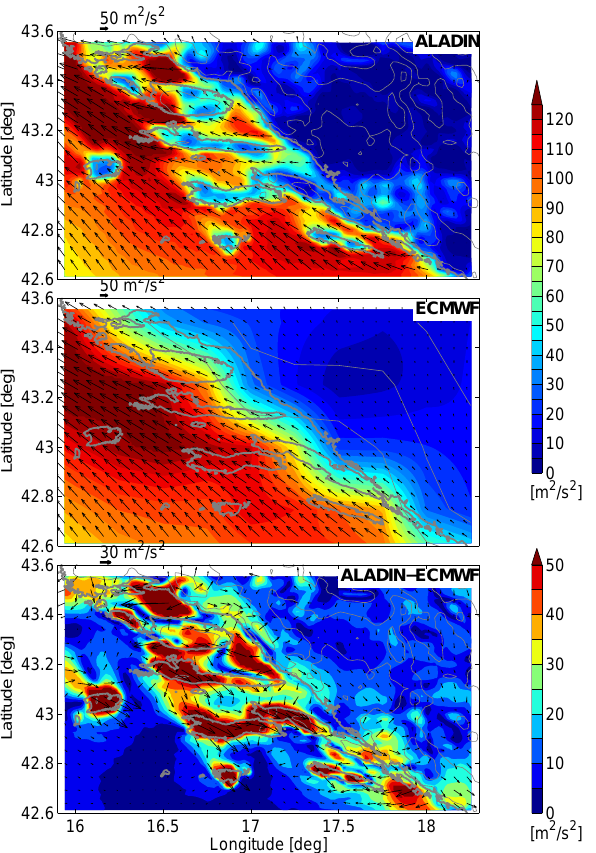
Fig. 8. Mean ASHELF-2 modeled vertically averaged currents for the Sirocco episode (Table 1) obtained with ALADIN and ECMWF forcing (top and center panels, respectively) and the differences be- tween these two (bottom panel). Additionally, the magnitudes of vector differences | ALADIN-ECMWF | are shown in